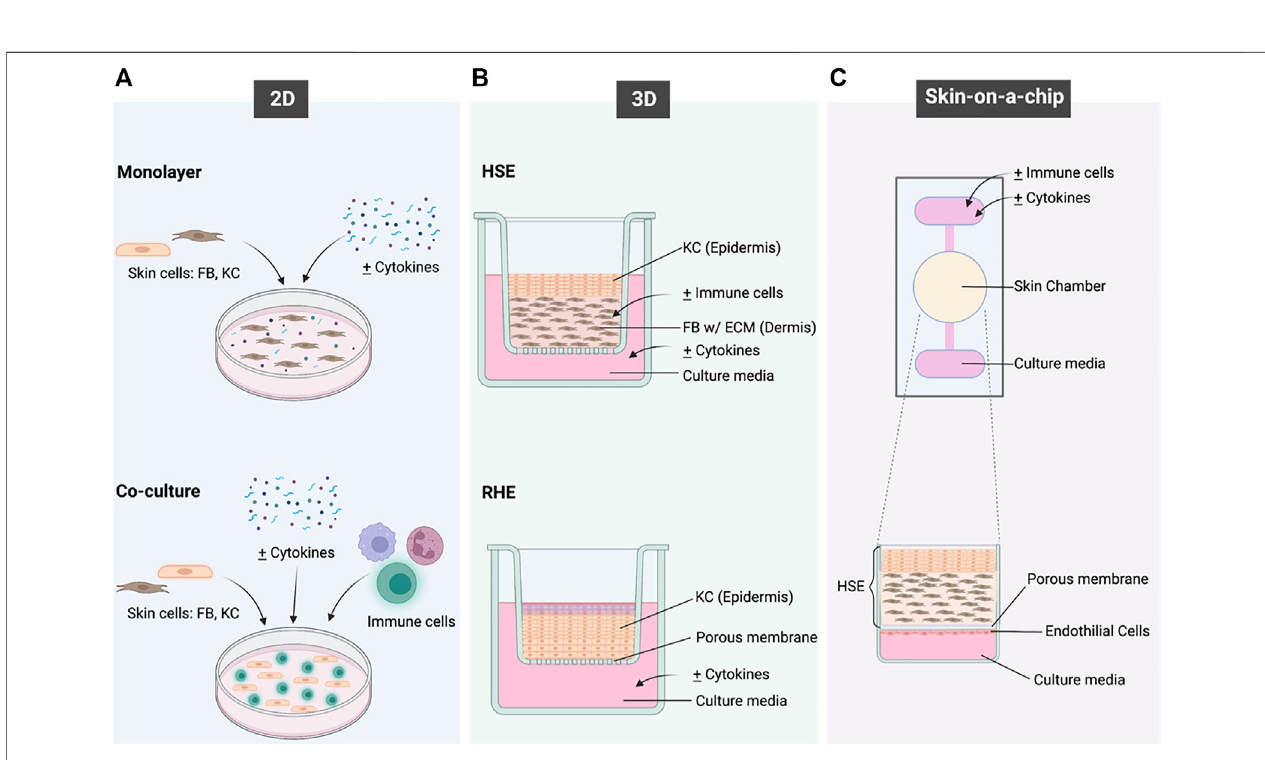
Frontiers in Bioengineering and Biotechnology |